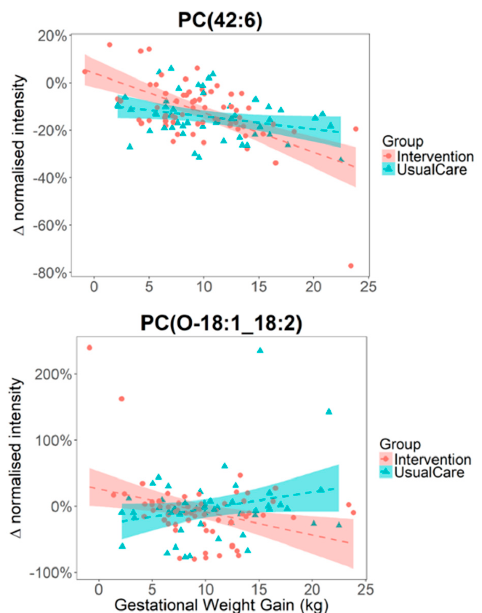
Figure 4. Intervention resulting in modest interactions to metabolite-GWG associations. The y-axes represent the change in metabolite intensity between the Baseline and W35 samples calculated per-participant and expressed in percentage change.